Question: Describe this figure in one sentence.
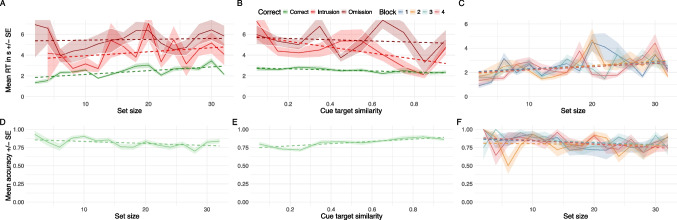
Answer: Results Experiment 1. A , B , and C The mean RTs (solid lines) and regressions (dotted lines) of the RTs. The shaded are represents the standard error. A and C The RTs across set sizes. In A , the colors represent the correctness of the response. In C , the colors represent the different blocks. Here, only correct responses are plotted. D , E , and F The same, but for accuracy. All shaded areas around the mean represent the standard error (SE) of the mean